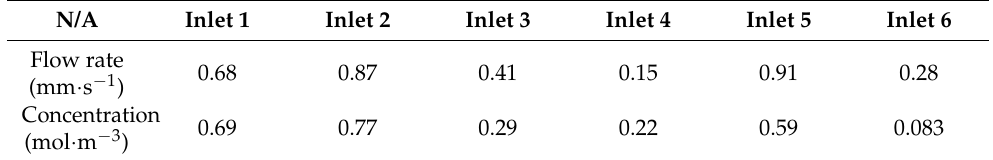
Table 1. The configuration of inlet boundary conditions for the demonstrated example in Figure 1B. N/A Inlet 1 Inlet 2 Inlet 3 Inlet 4 Inlet 5 Inlet 6 Flow rate 0.68 0.87 0.41 0.15 0.91 0.28 (mm · s − 1 ) Concentration 0.69 0.77 0.29 0.22 0.59 (mol · m − 3 )